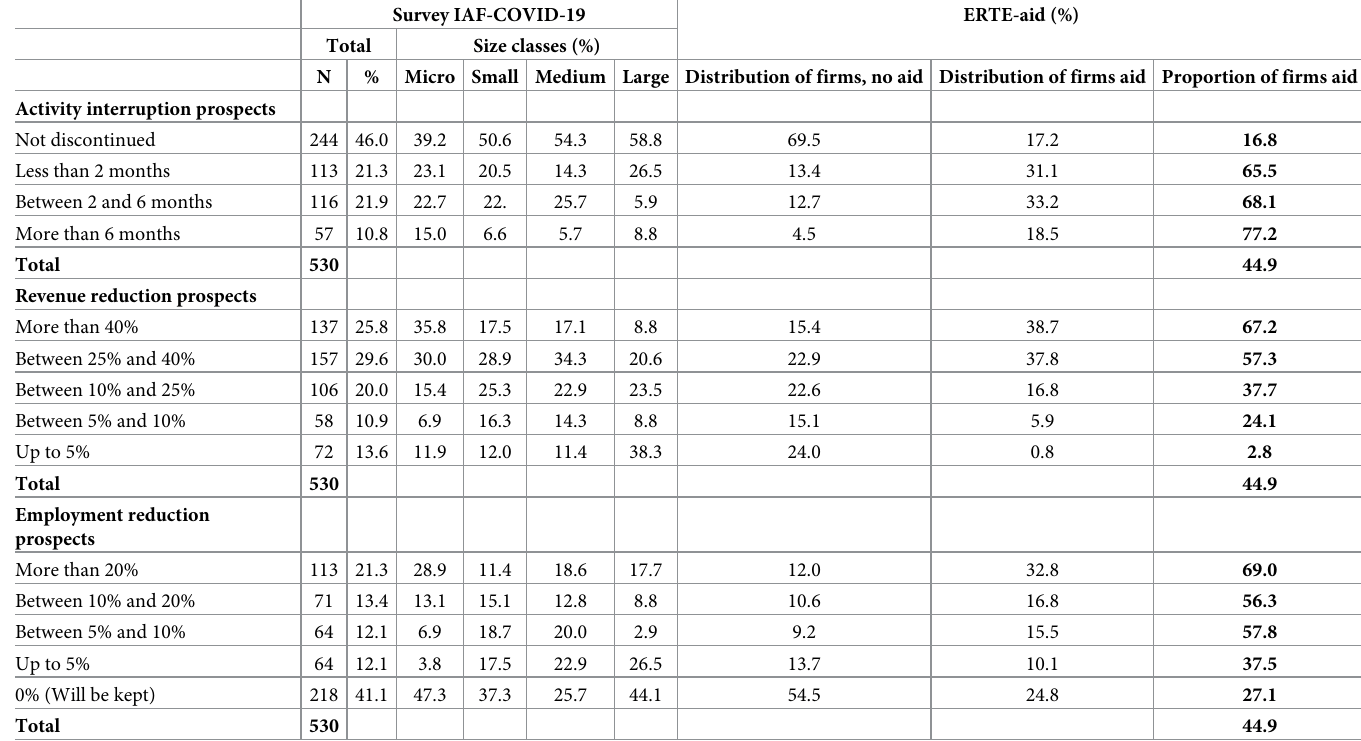
Table 3. Distribution of the sample of responding firms by their prospects for the next six months of activities, revenues, and